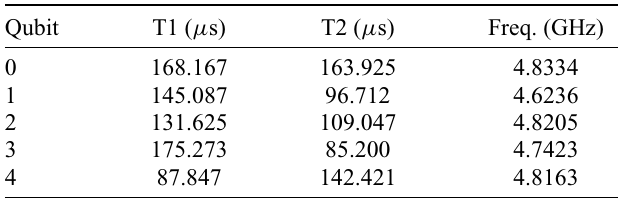
TABLE IV. Qubit relaxation time T1, dephasing time T2, and qubit frequency data of the 5-qubit machine ibmq-santiago downloaded from the IBM Quantum system service at the time when the numerical simulation is